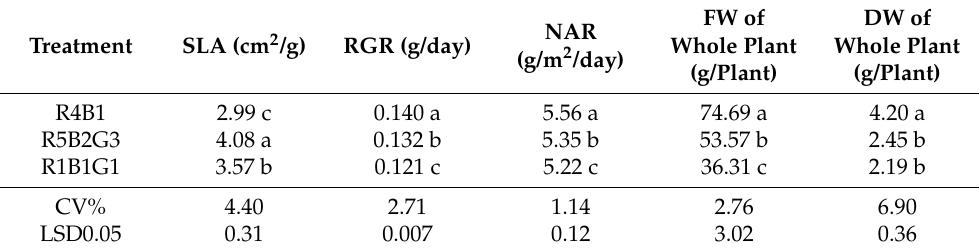
Table 1. Effects of different light qualities on the growth characteristics of hydroponically cultivated spinach (30 DAT).